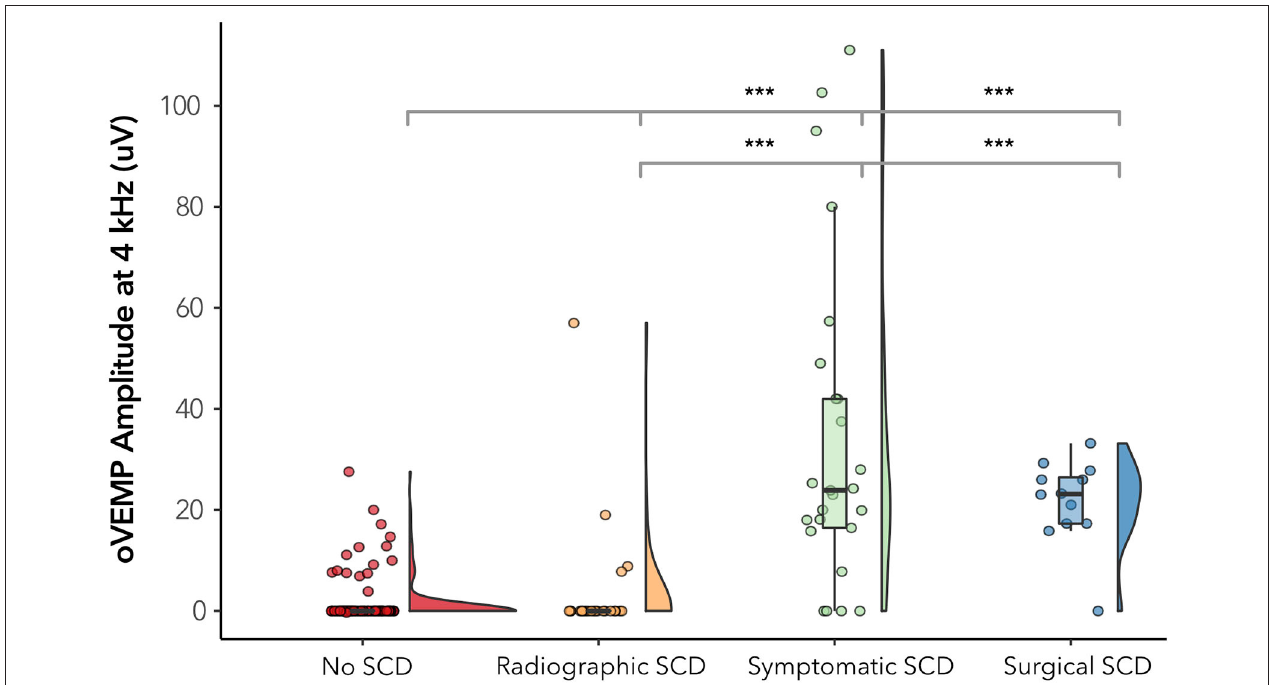
FIGURE 4 | 4kHz oVEMP amplitude across subgroups of SCD. “No SCD” represents cases without any evidence of dehiscence. “Radiographic SCD” are cases with radiographic dehiscence but no characteristic symptoms. “Symptomatic SCD” are cases with radiographic dehiscence and characteristic symptoms. “Surgical SCD” are cases that have undergone surgical repair of dehiscence. The width of the violin diagram depicts the distribution of data. Absence of asterisk (*) indicated p > 0.05 and *** p <